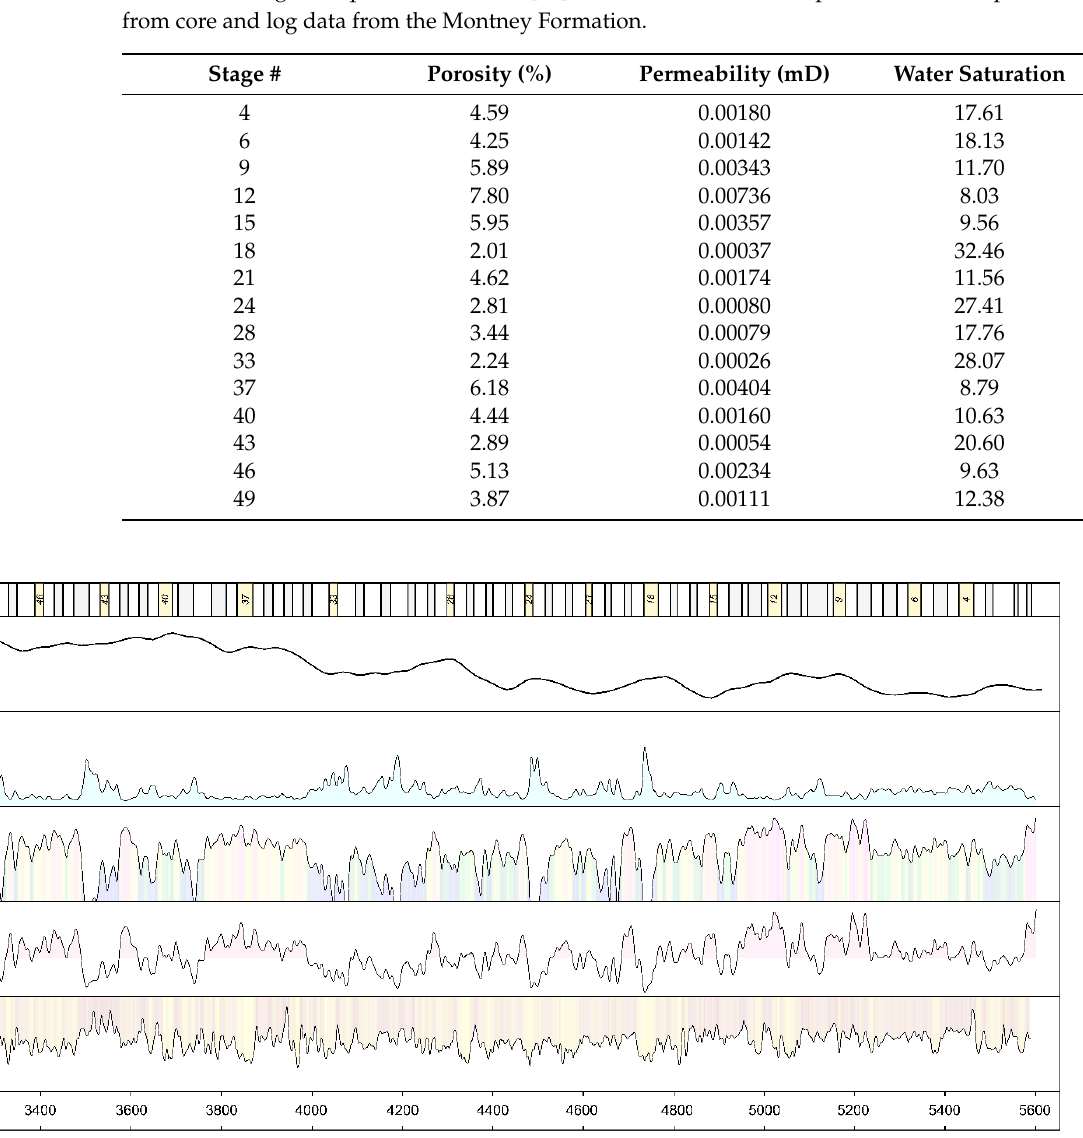
Table 6. Permeability, porosity, and initial water saturation-based ranking for the selected stages.